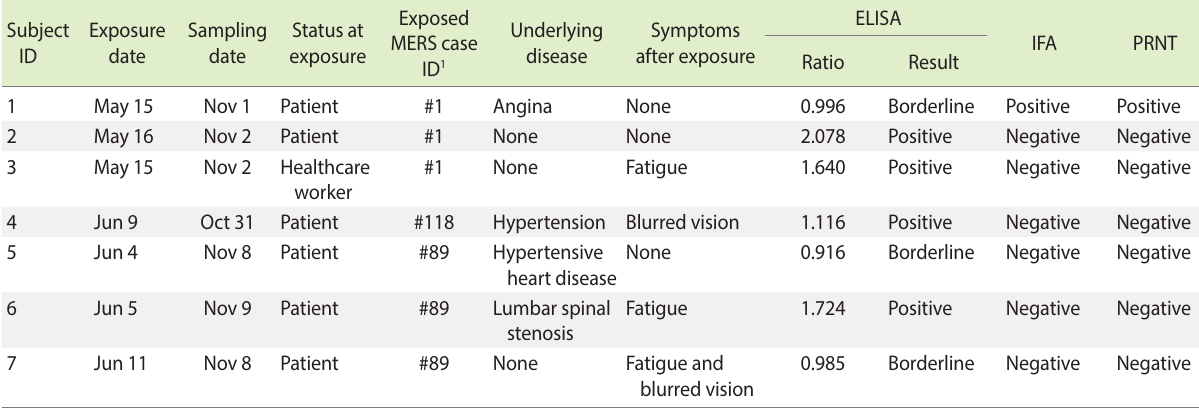
Table 2. Characteristics of MERS-seropositive subjects by ELISA, IFA, and PRNT in Korea,